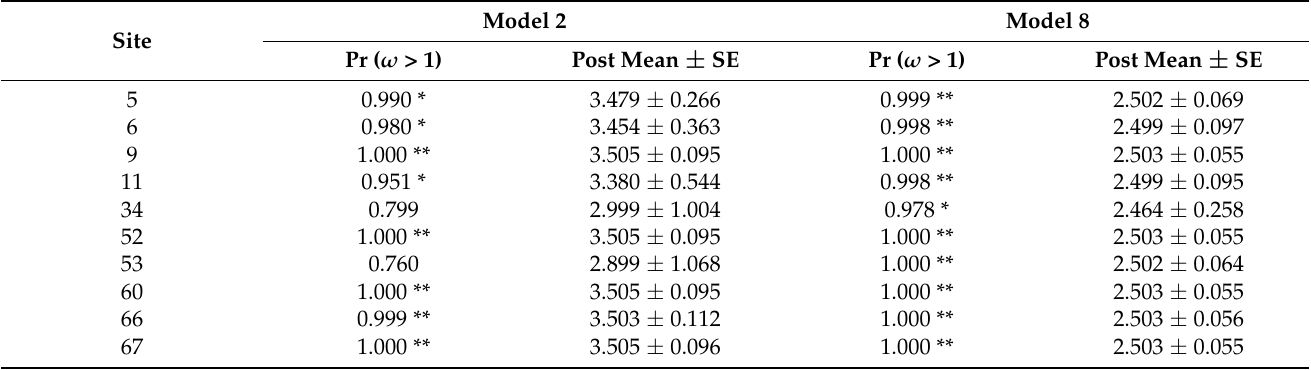
Figure 3. Positive selection on amino acid sites. A sequence logo showing the relative frequencies of amino acids of the fragment of the MHC class I exon 3. The plot is based on sequences of all putative expressed alleles. Sites under positive selection are indicated with asterisks for sites with high polymorphism and dots for sites with low polymorphism. Table 3. Ten positively selected sites detected by the Bayes empirical Bayes (*: p > 95 %; **: p >